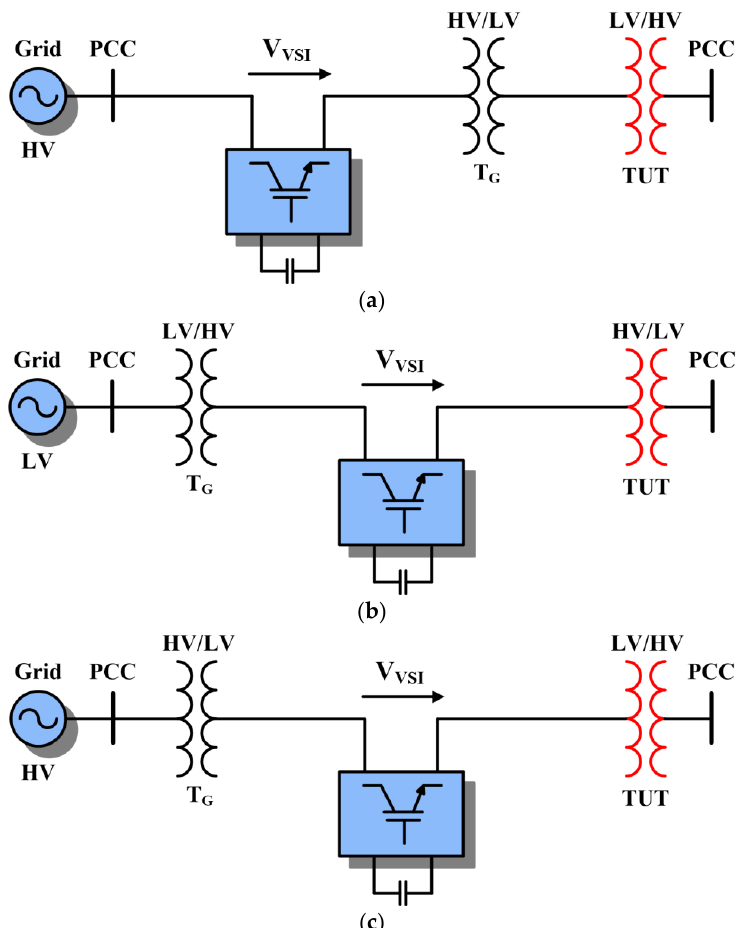
Figure 3. Proposed structure using partial power converter ( 𝑉̇ 𝑉𝑆𝐼 ): ( a ), ( b ) with lower current converter and ( c ) with lower voltage converter to test transformer under test (TUT) highlighted (red).